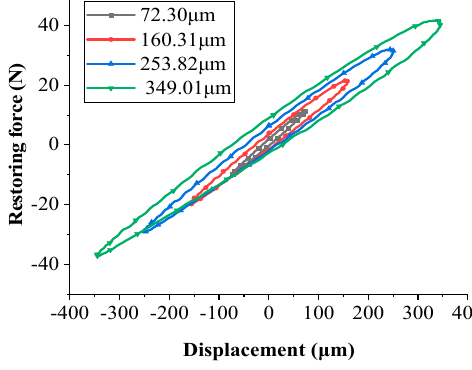
Figure 7. Hysteresis loop at different amplitudes A (f = 10 Hz).